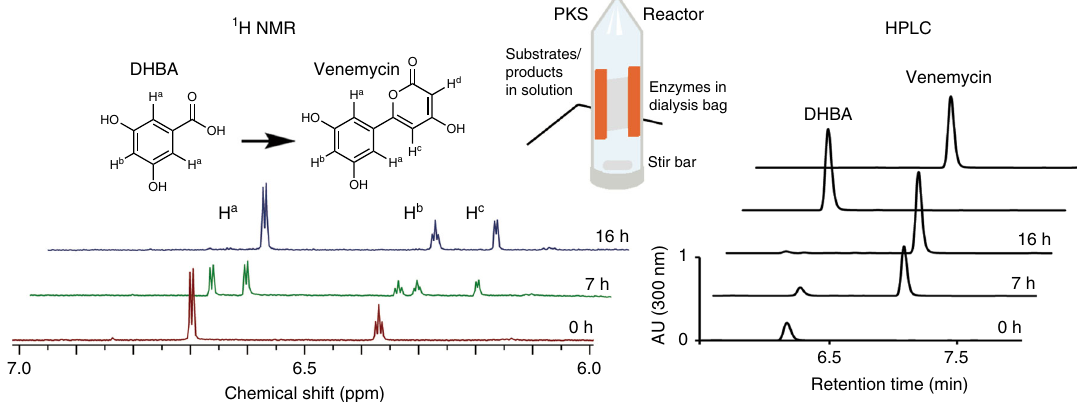
Fig. 3 The PKS reactor facilitates scaled-up reactions. The 100 kDa MWCO dialysis bag ensures high concentrations of the assembly line polypeptides, facilitates analysis of the reaction by NMR and HPLC, and enables transfer of the enzymes to subsequent reactors (half-life: 2 Scienti fi c. MonoQ 5/50, Superdex 200 Increase 10/300, Sephacryl S-300 HR, HiLoad 16/600 Superdex 200 pg, and Superdex 200 Increase 16/600 GL are from GE Healthcare. Magnesium chloride is from MACRON. Tris(hydroxymethyl) aminomethane is from MP Biomedicals. Malonic acid and methylmalonic acid are from Oakwood Chemical. 3,5-Hydroxybenzoic acid, magnesium sulfate, sodium succinate, 4-hydroxy-6-methyl-2-pyrone, adenosine triphosphate (ATP), imidazole, and glycine are from Sigma-Aldrich. Coenzyme A (CoA) is from Oriental Yeast Co., Ltd. 3-Hydroxybenzoic acid is from Alfa Aesar. Amicon Ultracentrifugal protein concentrators fi lters are from Millipore. Ethyl acetate (EtOAc), acetonitrile, methanol, chloroform, and hexanes are from Fisher Scien- ti fi c. D 2 O, CDCl 3 , and DMSO-d 6 are from Cambridge Isotope Laboratories. SiliaFlash Irregular Silica Gels are from SiliCycle. FPLC chromatography was performed using a Biologic DualFlow instrument (Bio- Rad). HPLC analysis was carried out on a Waters 1525 HPLC system. High-resolution mass spectral analysis was conducted on a 6230 TOF LC/MS (Agilent Technologies). 1 H and 13 C NMR spectra were collected on a Bruker AVIII HD 400 (400MHz) supported by Grant Willson and Benjamin Keitz (CHE-1626211) and Bruker AVIII HD 500 (500MHz) supported by Jonathan Sessler (NIH 1 S10 OD021508-01). E. coli DH5 α was used for plasmid construction. BL21(DE3)star pLysS cells were used for MatB expression. E.coli K207-3 cells were used for the expression of assembly line enzymes 13 .